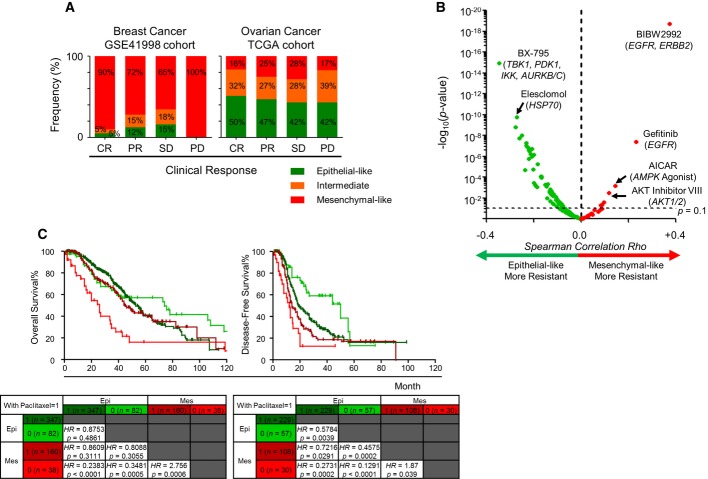
Generic epithelial-mesenchymal transition (EMT) and drug sensitivityBar plots of breast (n = 270; left panel) and ovarian (n = 328; right panel) cancers stratified by EMT status and clinical response based on response evaluation criteria in solid tumours (RECIST). Regimen was neoadjuvant doxorubicin and cyclophosphamide for breast cancer, and platinum-based adjuvant/progression/recurrence chemotherapy for ovarian cancer. Percentage distribution of EMT status is given in each clinical response group. Abbreviation: CR, complete response; PR, partial response; SD, stable disease; PD, progressive disease. Green, epithelial-like (Epi); orange, intermediate; red, mesenchymal-like (Mes).Volcano plot of EMT correlation with drug sensitivity regardless of cancer type.Rho ∈ [−1.0, +1.0] (x-axis) and-log10P-value (y-axis) were computed by Spearman's correlation coefficient test. Dashed line ofP-value = 0.1 is plotted. Red and green indicate higher drug resistance in Mes tumours (Rho ∈ [0, +1.0]) and Epi tumours (Rho ∈ [−1.0, 0]), respectively.Kaplan–Meier analysis comparing overall survival (left panel) and disease-free survival (right panel) of Epi (green) and Mes (red) ovarian cancer patients who underwent a treatment regimen with (dark colour) or without (light colour) paclitaxel.P-value reported was computed by log-rank test. Abbreviation: HR = hazard ratio.